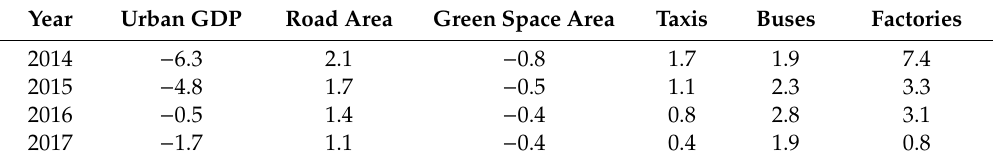
Table 2. Mean value of spatial regression coe ffi cient of GWR model ( × 10 − 3